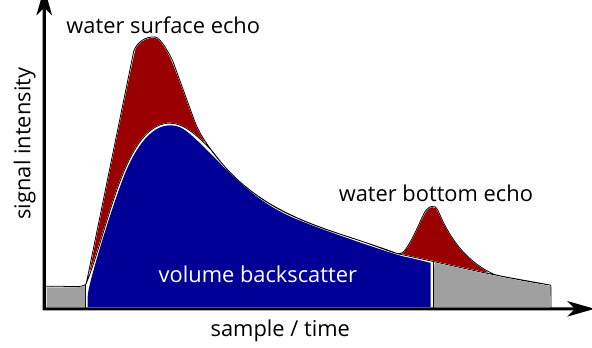
Figure 1. Schematic full-waveform representing the three signal components according to Guenther et al. (2000).